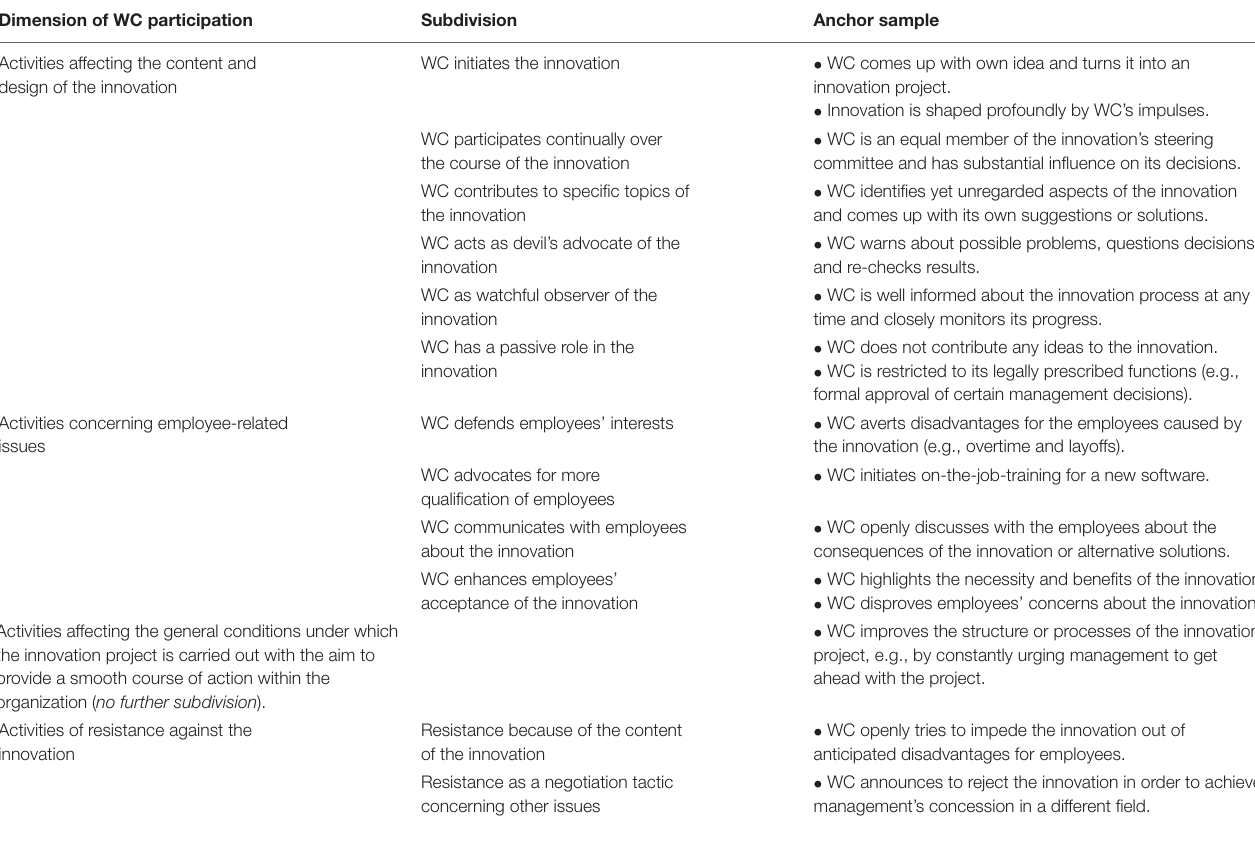
TABLE 1 | Category system for the analysis of the works council (WC) participation during innovation. Dimension of WC participation